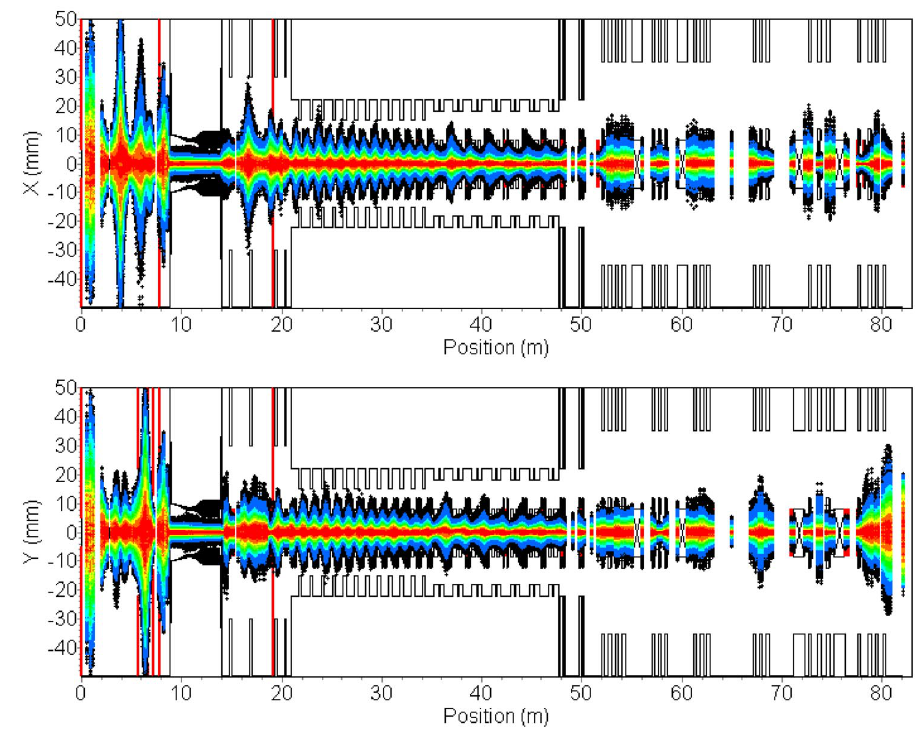
FIG. 2. (Color) The deuteron density projection in the transverse plane in the SPIRAL2